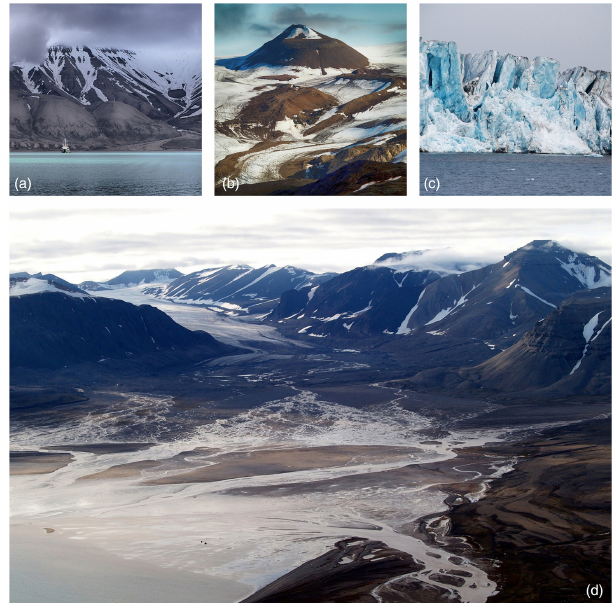
Figure 8. Svalbard landscapes in the Svalbard archipelago, Nor- way. (a) Longyearbyen Bay with tundra landforms during the RV Polarstern expedition PS99-1a under the Eurofleets 2 project of “Bottom currents in a stagnant environment” (BURSTER). (b) A view from the Wordiekammen plateau towards the Ebbabreen, with the Bastion Nunatak, under the Paleokarst project. (c) The front of the Bellsund ice stream in southwestern Svalbard during the RV Ian Mayen 2009 expedition under the University of Tromsø (UiT) “Glaciations in the Barents Sea Area” (GLACIBAR) project. (d) The view from the Wordiekammen plateau towards the Petuni- abukta, with the waters from Horbyedalen and Ebbadalen, under the Paleokarst